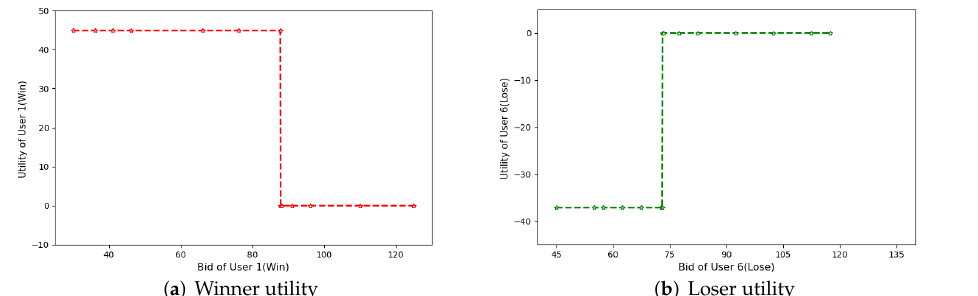
Figure 9. Truthfulness